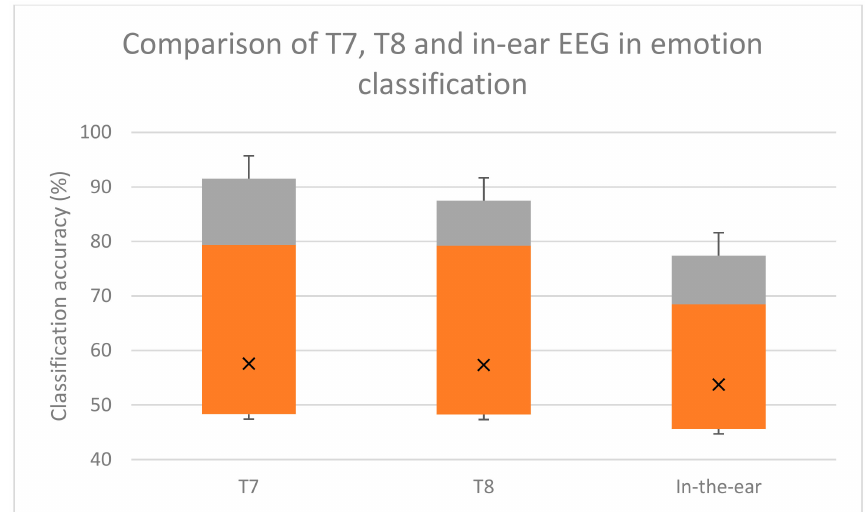
Figure 8. Box plot comparison among emotion classification using single channel T7, T8, and in-ear EEGs. Grey areas indicate proportions of classification accuracy above the median. Orange areas indicate proportions of classification accuracy below the median. X indicates the mean